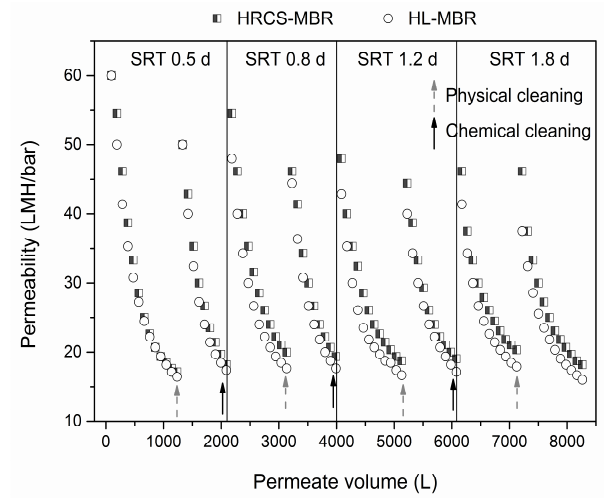
Figure 7. Evolutions of permeability as a function of permeate volume in two MBRs at different